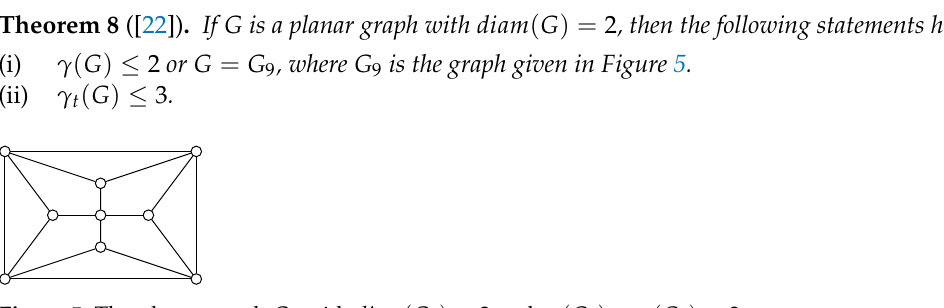
Figure 5. The planar graph G 9 with diam ( G 9 ) = 2 and γ t ( G 9 ) = γ ( G 9 ) =